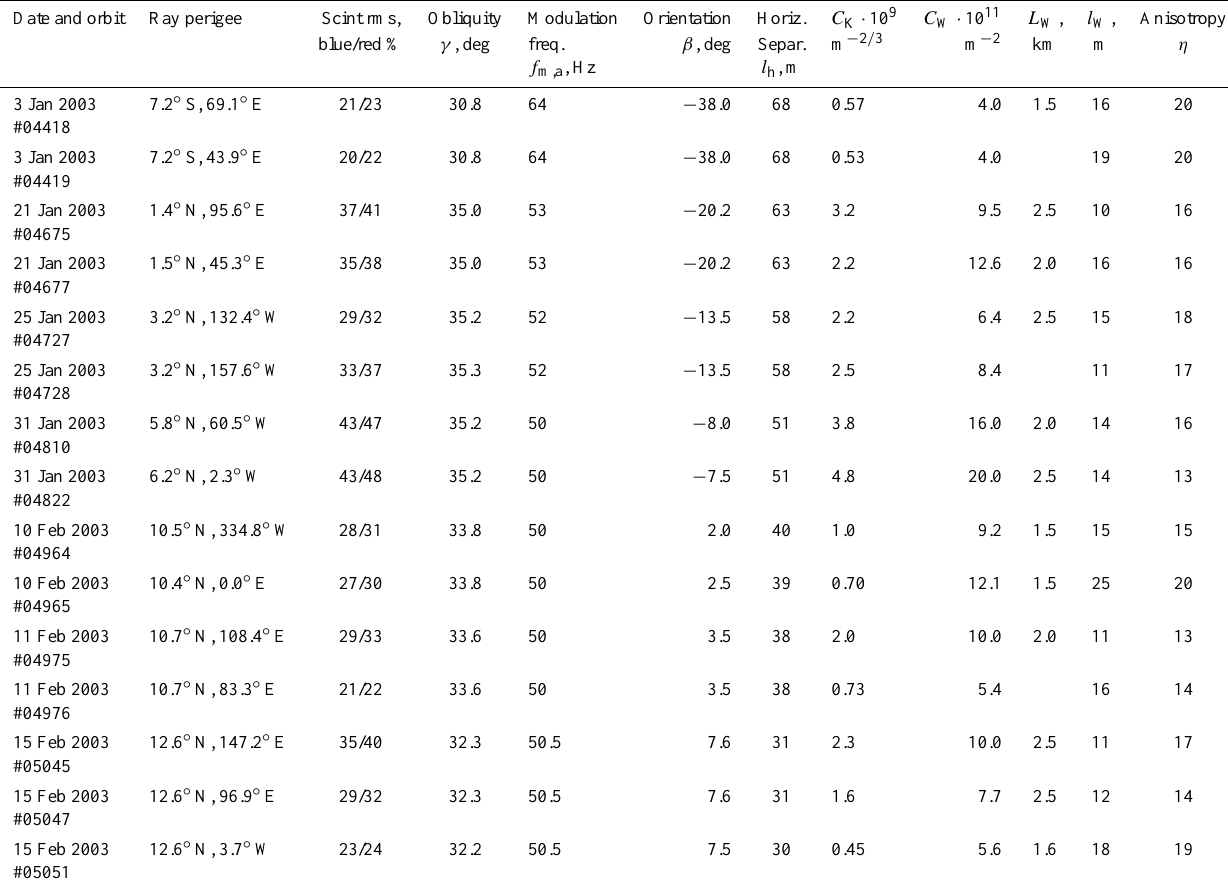
Table 1. Information about the selected occultations of α